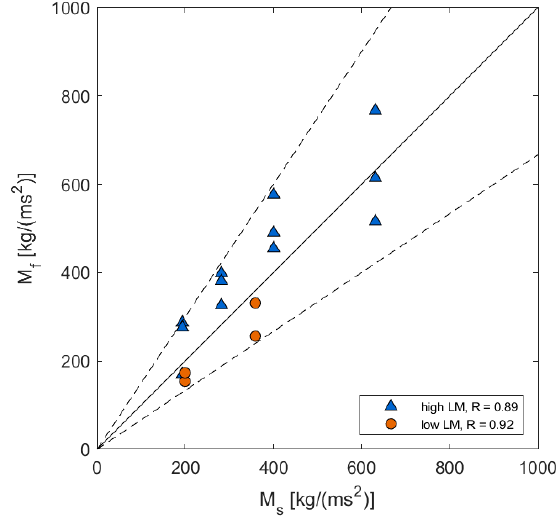
Figure 4. Balance of momentum terms for a set of experiments with waves generated by landslides with low and high mobility. The solid line represents perfect correlation, the dashed lines are ± 15% deviation, and correlation coe ffi cients for each type of slide are